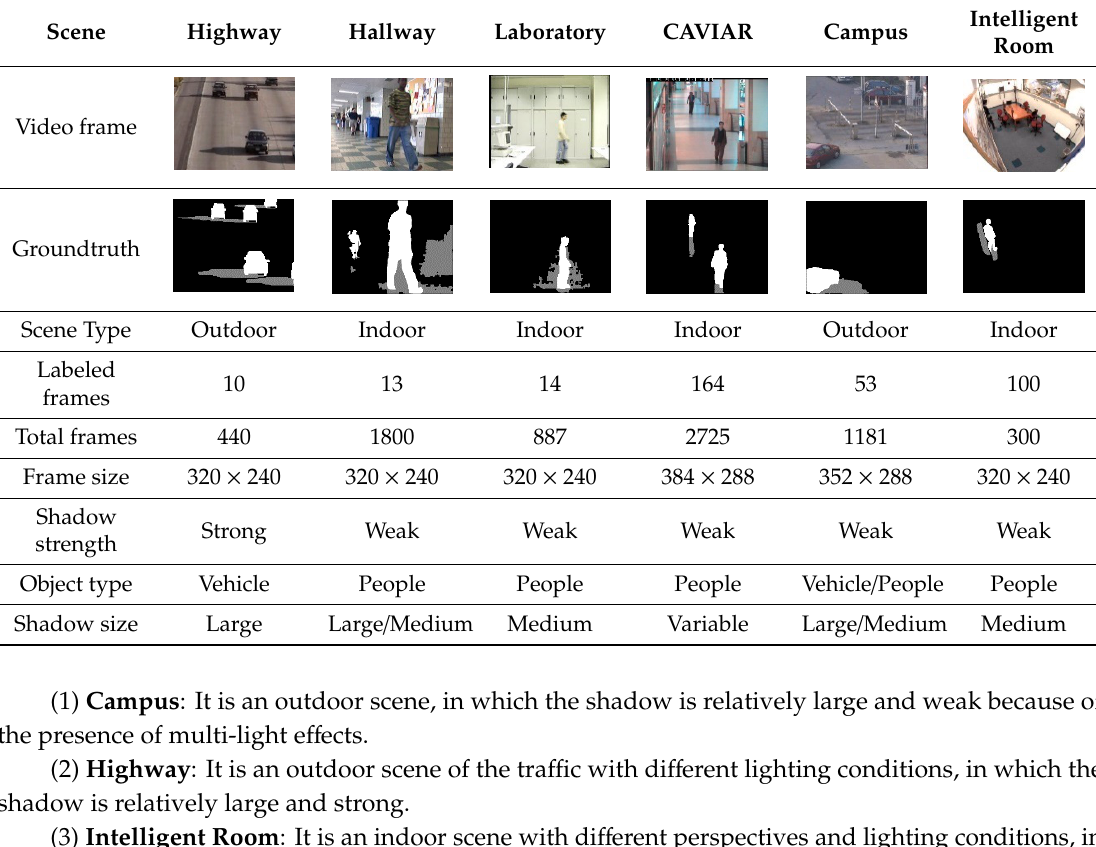
Table 1. The detailed information of a popular